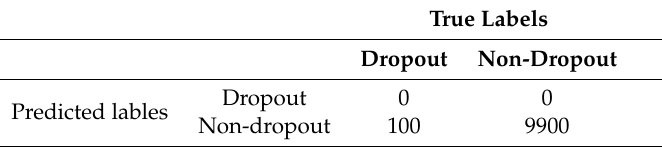
Table 3. The hypothetical confusion matrix showing the case where the accuracy of a binary classifier can be deceptive for an imbalanced dataset. In this example, the proportions of dropouts and non-dropouts are imbalanced, i.e., 100 dropouts (1%) vs. 9900 non-dropouts (99%). Despite of the complete misclassifications of the dropouts, the accuracy is still 0.99 = ( 0 + 9900 ) / ( 0 + 0 + 100 + 9900 ) = 9900/10000 because the correct predictions of the non-dropout dominate the